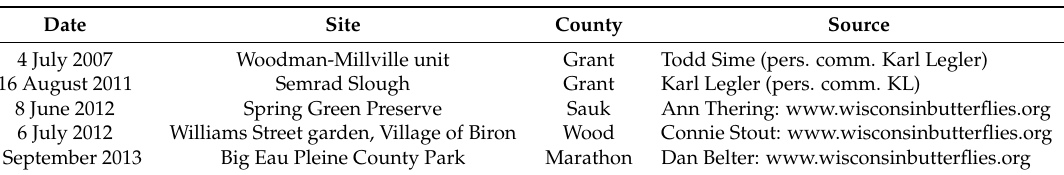
Table 3. Regal fritillary records reported directly to us or to a reporting website, representing sites without a known Regal population.